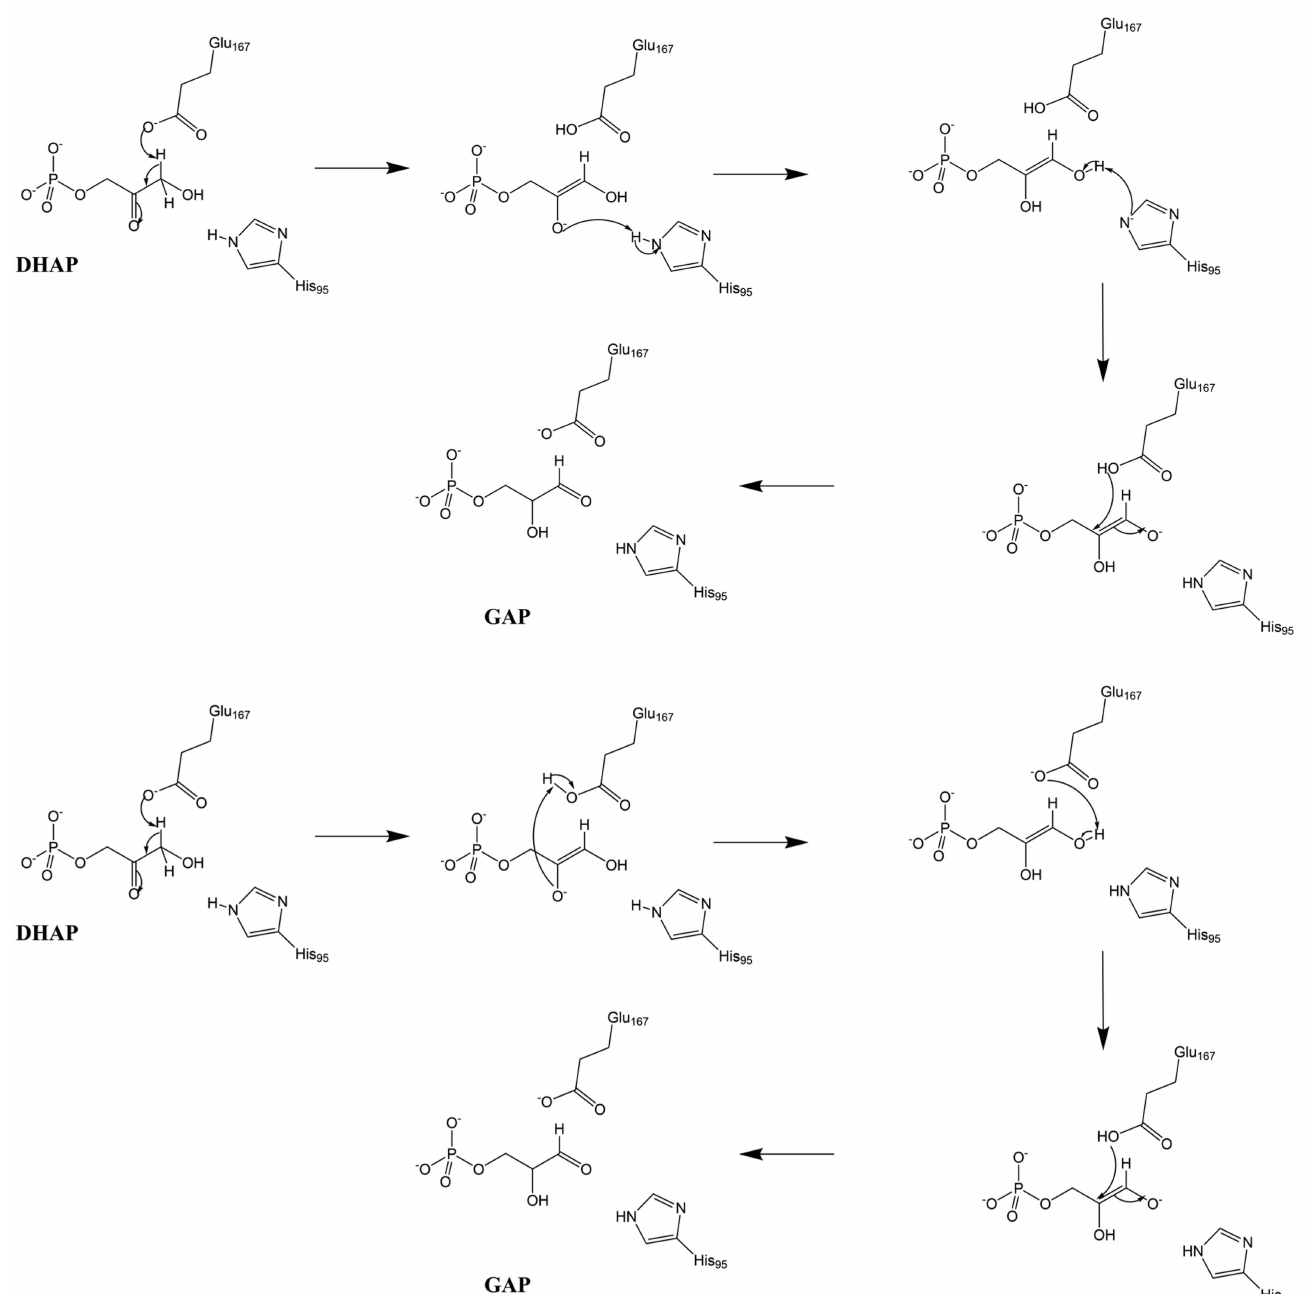
Figure 1 The classical (top) and criss-cross (bottom) mechanisms for the isomerization of DHAP to GAP catalyzed by TIM. The shuffle mechanism skips the enediol intermediate in the classical mechanism (not